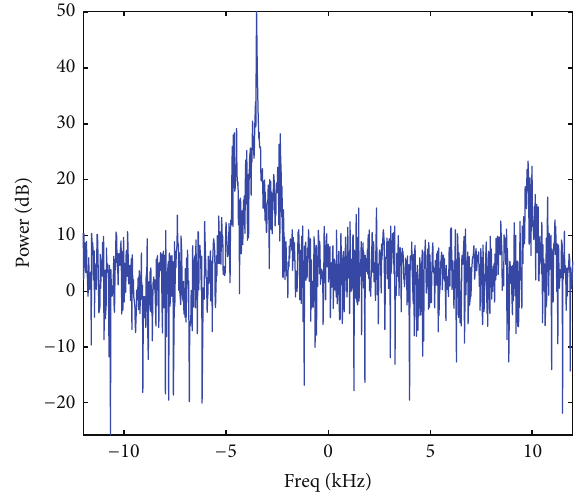
Figure 6: Frequency spectrum of time sample